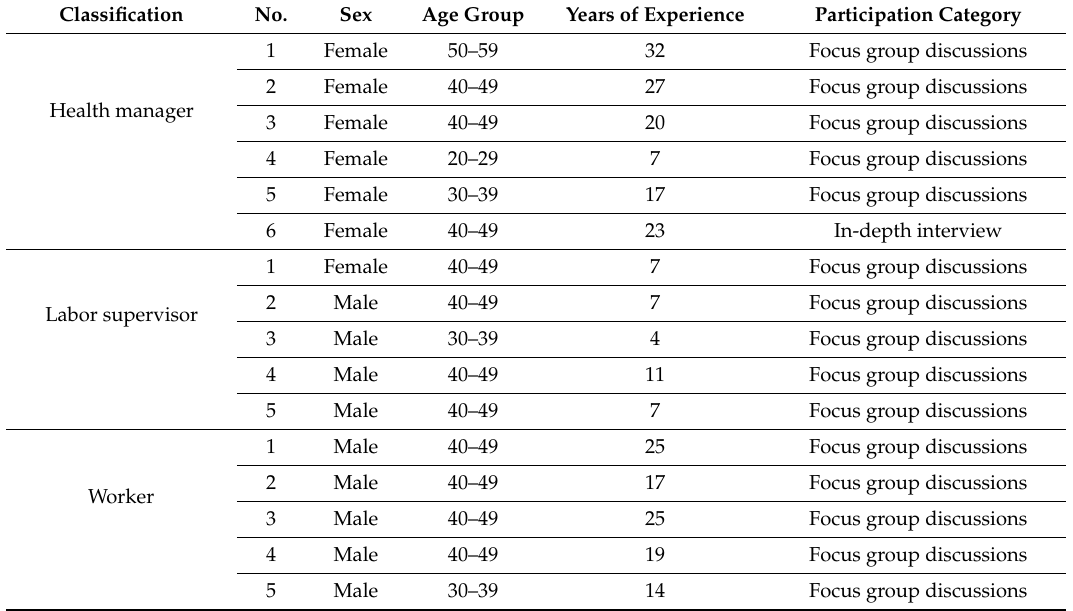
Table 1. Socio-demographic characteristics of